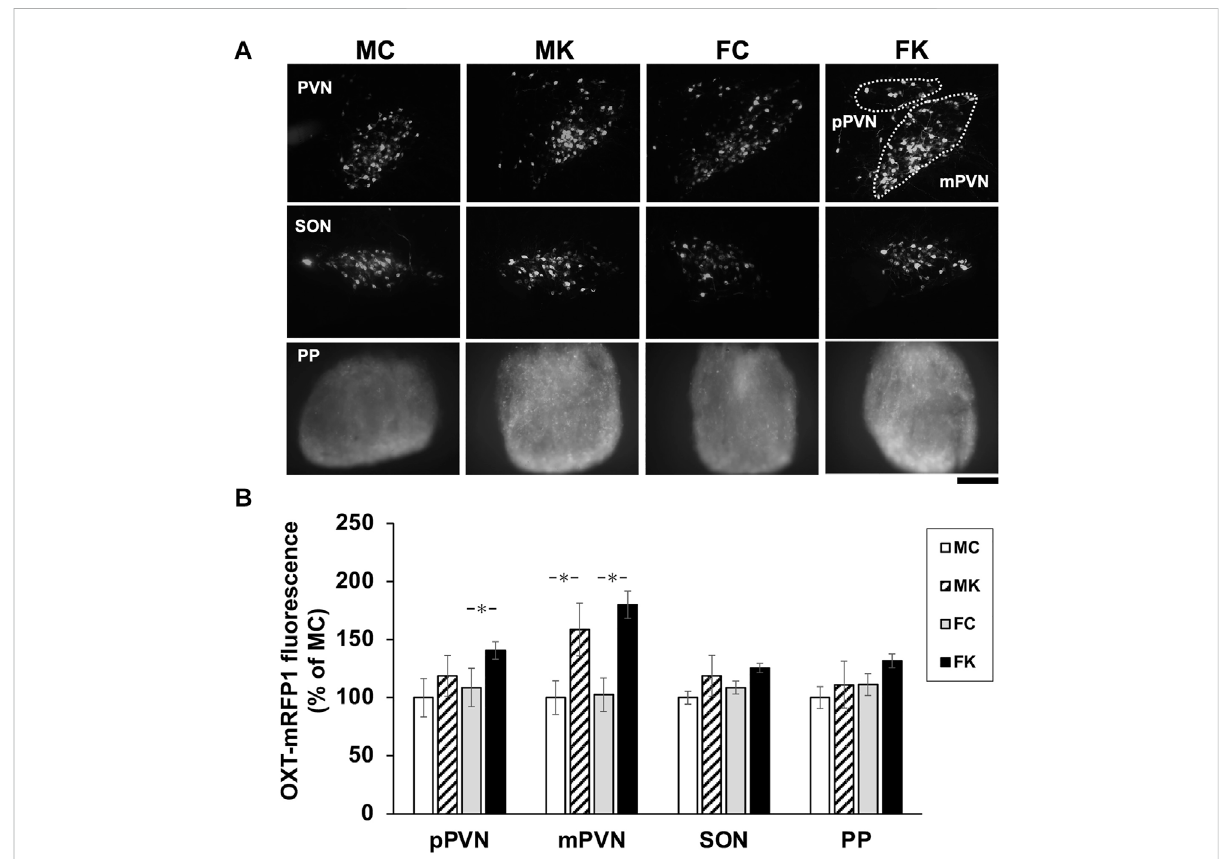
FIGURE 4 Time-course studies showing the effects of intraperitoneal administration of saline or cholecystokinin (CCK)-8 (20 g/kg) on cumulative food intakeinthecontrol groupandKamikihi-to(KKT)-treatedgroup onmalerat (A) andfemalerat (B) .Dataforcumulativefoodandarepresentedasthe mean ± standard error ofthe mean (each group, n = 6).* p < 0.05 compared between thecontrol and KKT groups; # p < 0.05 compared betweenthe saline and CCK